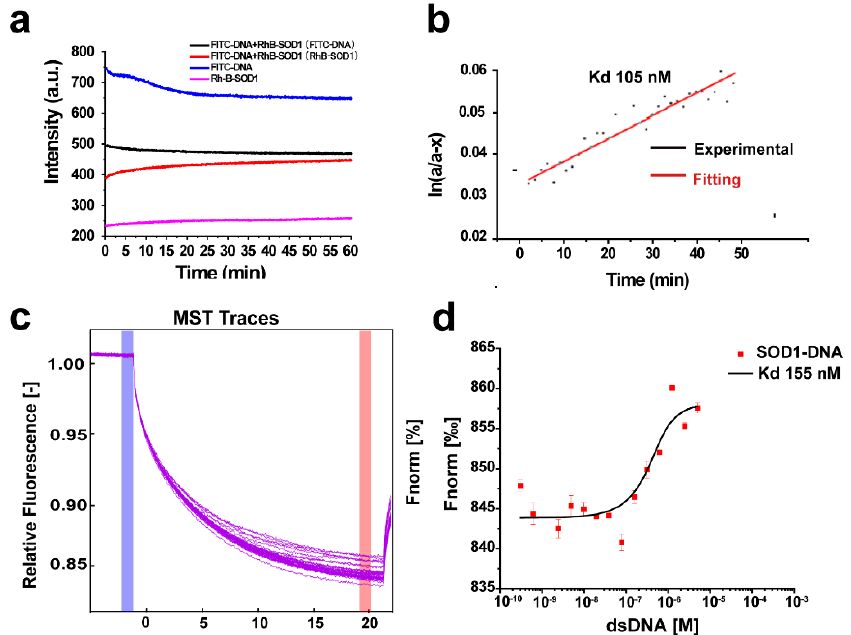
Figure 1. FRET and MST determinations of the dsDNA binding of SOD1. ( a ) 100 µ M FITC-dsDNA and 200 µ M RhB-SOD1 were mixed and immediately excited at 450 nm in 20 mM Tris-HCl (pH 7.4). ( b ) The binding affinity ( K d ) of SOD1-RhB for FITC-dsDNA was calculated based on kinetic curves. ( c ) MST traces of SOD1 and DNA. ( d ) Binding of SOD1-RhB to dsDNA and fitting of affinity ( K d ). Samples were tested in the red channel by MST; excitation power: auto-detect 20%, MST power: medium. MST data were processed using MO. Control V1.6.1 and MO. Affinity Analysis V2.3.